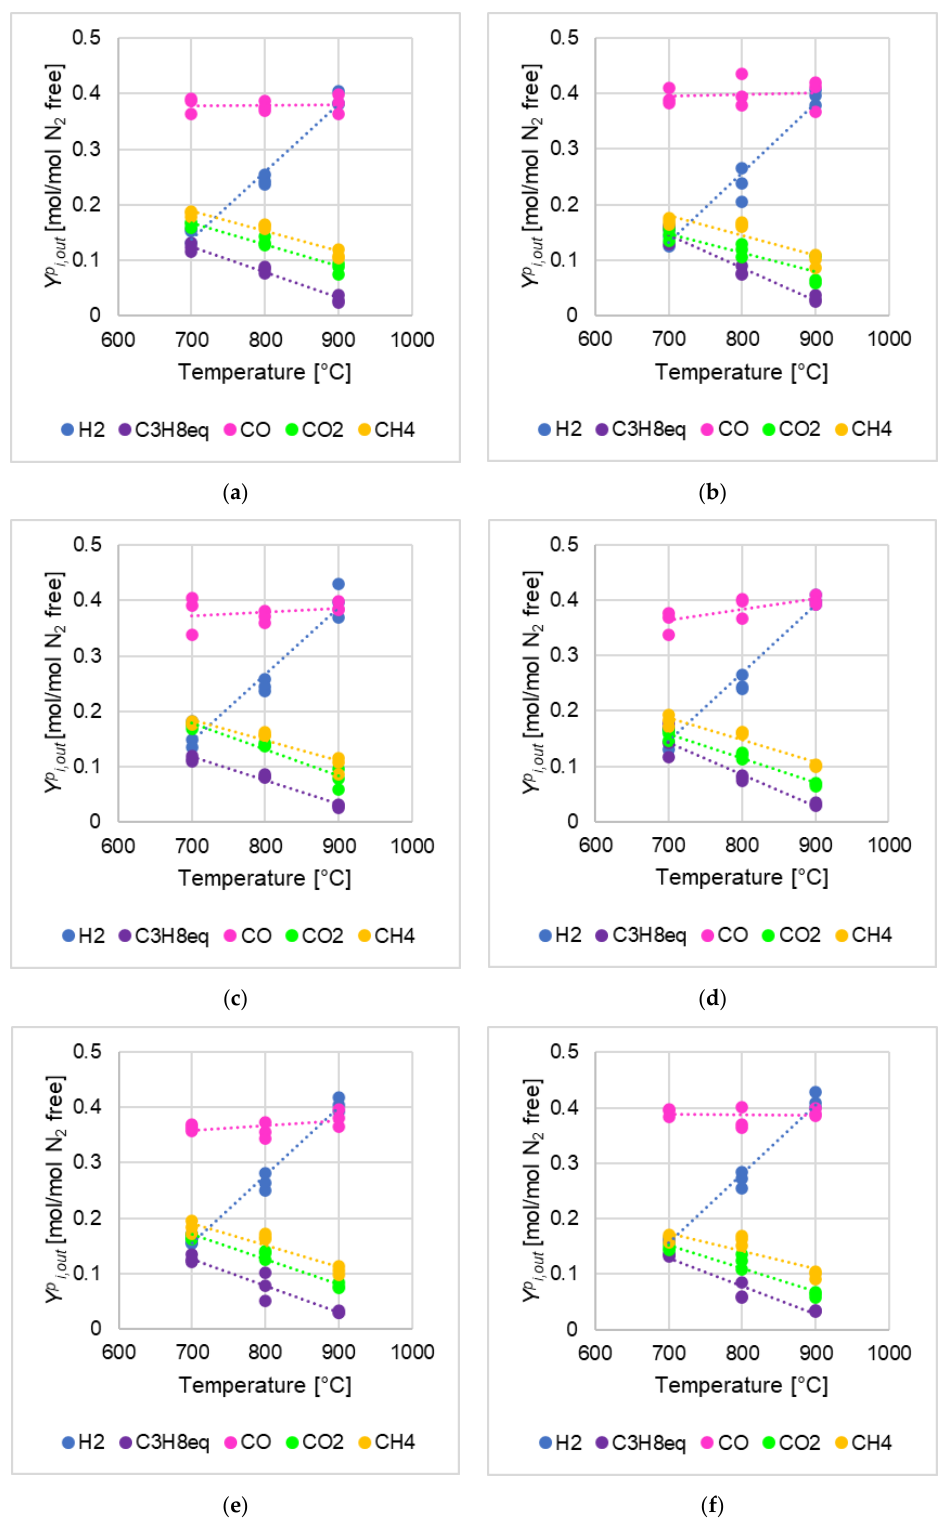
Figure 4. Experimental results from devolatilizations of torrefied and torrefied-washed pellets. Molar fractions on N 2 free-basis of produced gases at devolatilization peaks ( Y p , Equation (5)), as functions of temperature (points), with i , out regression straight lines (dotted), for: ( a ) WSP-T1; ( b ) WSP-T1W; ( c ) WSP-T2; ( d ) WSP-T2W; ( e ) WSP-T3; and ( f )